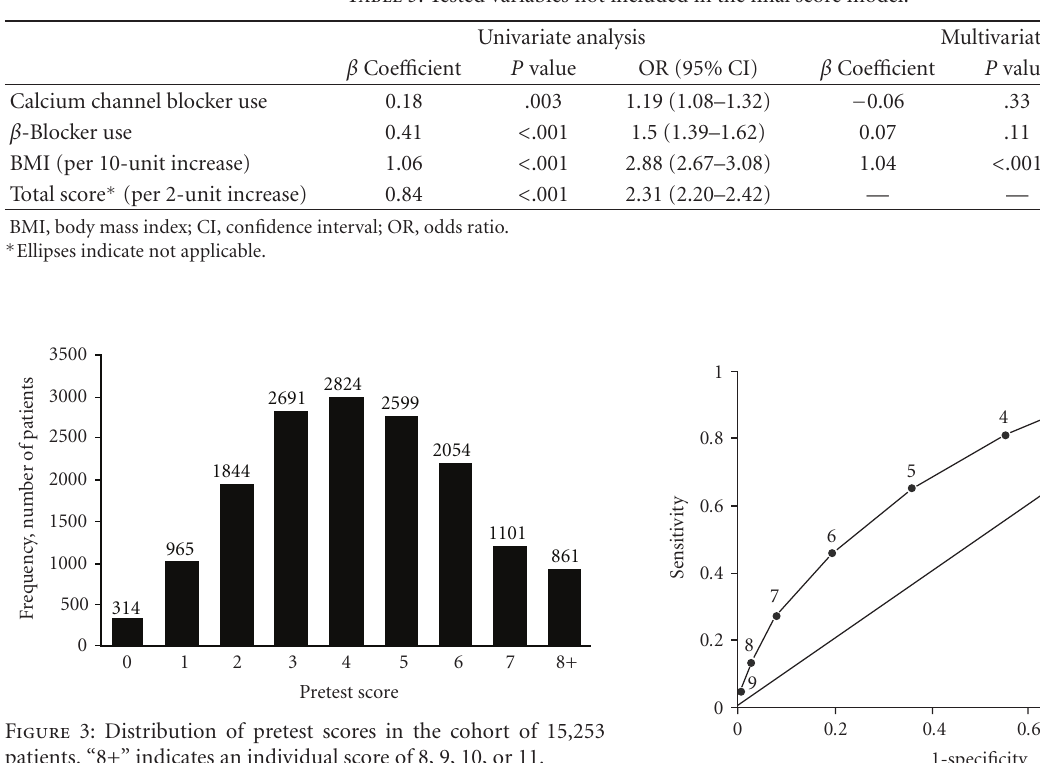
Table 3: Tested variables not included in the final score model.